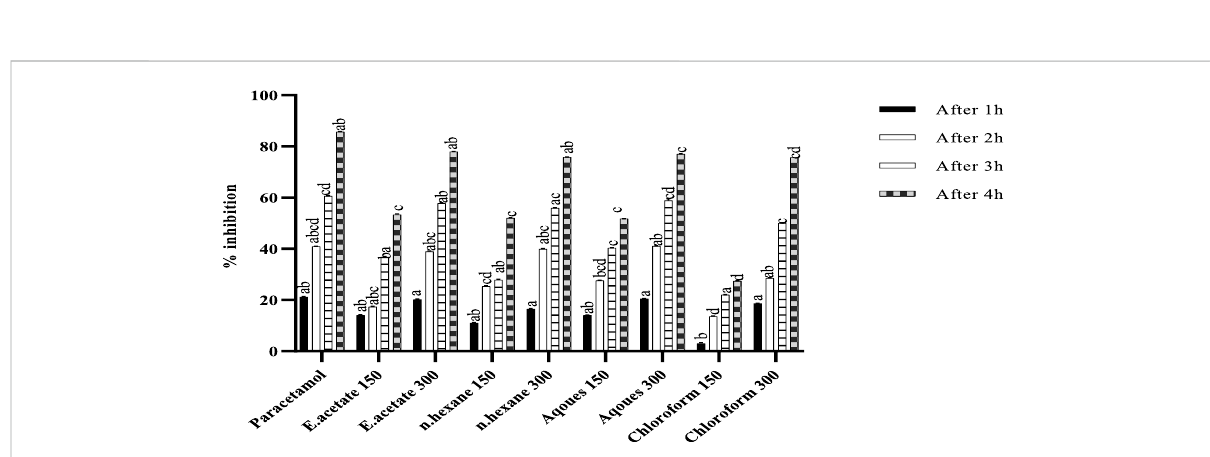
FIGURE 5 Antipyretic activity of various fractions of Justicia adhatoda at doses of 150 and 300 mg/kg by brewer ’ s yeast-induced pyrexia in Swiss albino mice after 1, 2, 3, and 4